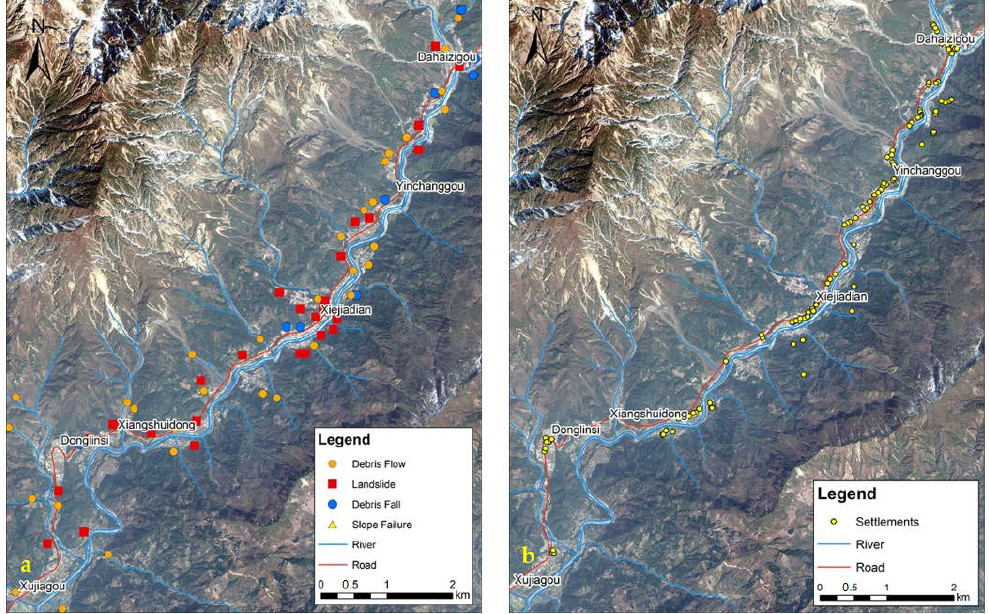
Figure 3. Distribution of co-seismic and post-seismic potential geohazards ( a ) and settlements investigated ( b ) in the study